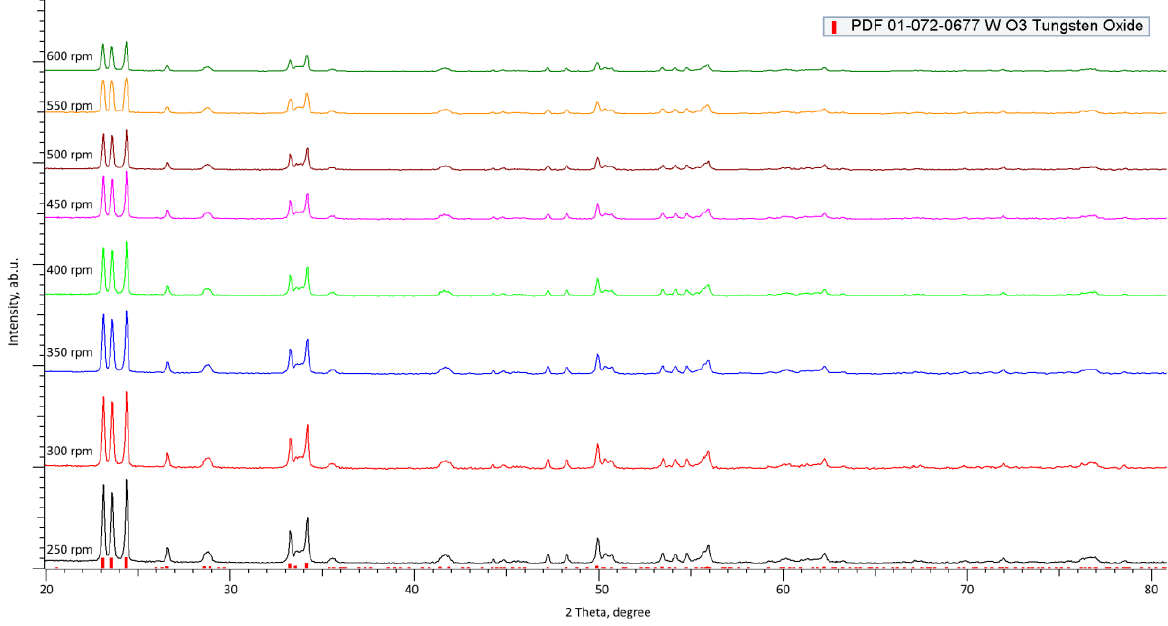
Figure 1. Results of X-ray diffraction of the studied